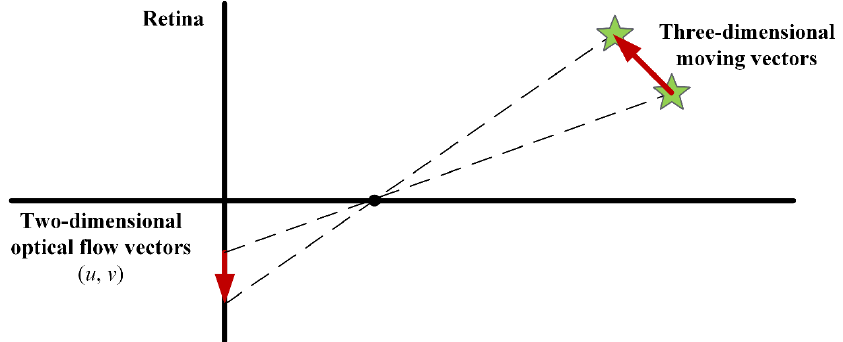
Figure 1. Optical-flow-field theory.